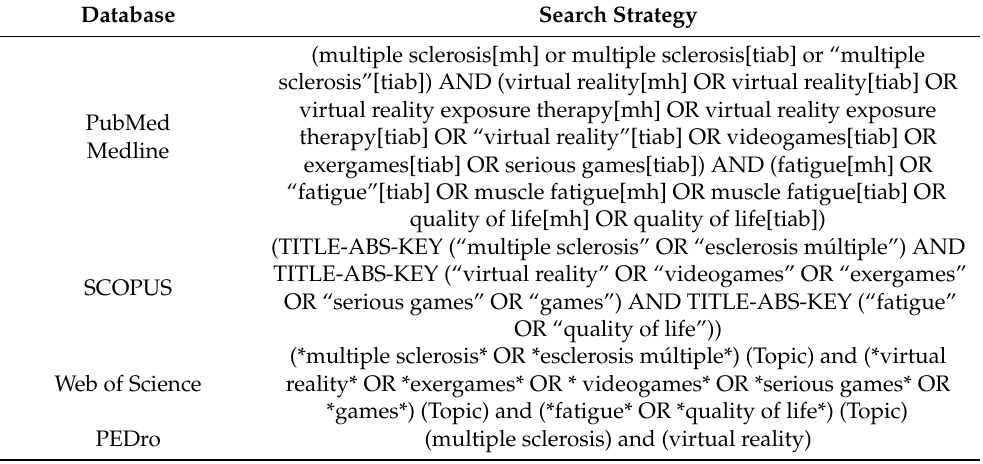
Table 1. Search strategy in each